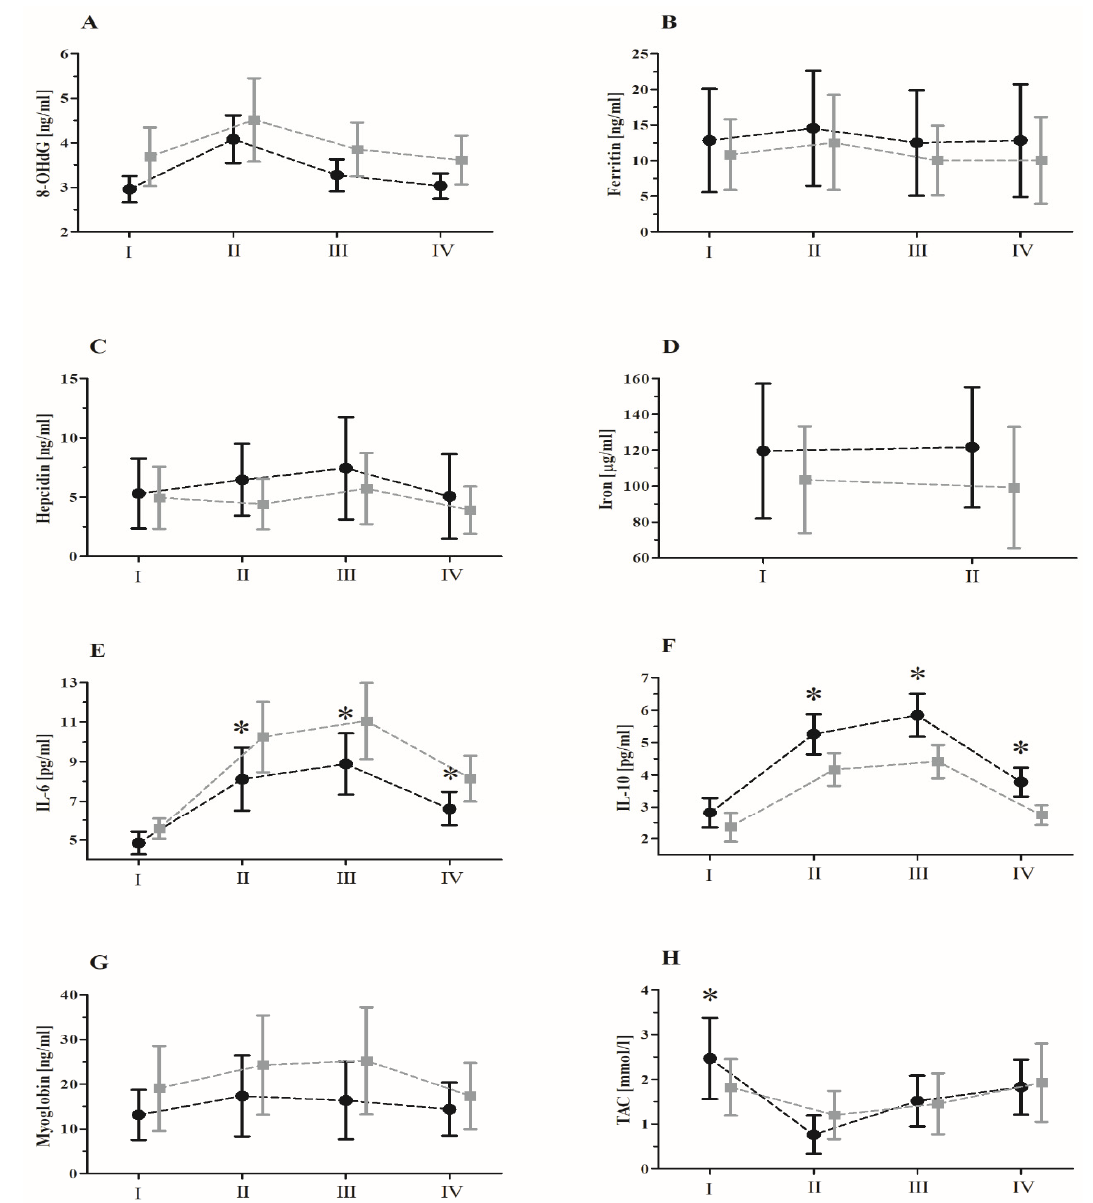
Figure 2. The mean ± SD values of serum levels of specific inflammatory markers induced by maximal aerobic effort (MAE) after 90 days of supplementation with a lyophilizate of black chokeberry extract: ( A ) 8-OHdG, ( B ) ferritin, ( C ) hepcidin, ( D ) iron, ( E ) IL-6, ( F ) IL-10, ( G ) myoglobin, and ( H ) TAC. Black circles, supplemented group ( n = 12); gray squares, placebo group ( n = 10). Abbreviations: I, baseline; II, immediately after MAE; III, 6 h post MAE; IV, 24 h post MAE; 8-OHdG, 8-hydroxydeoxyguanosine; IL-6, interleukin 6; IL-10, interleukin 10; TAC, total antioxidant capacity; * significant difference vs. placebo at the particular time point.